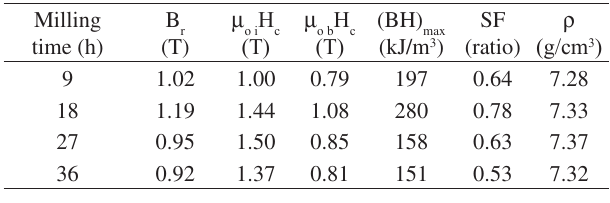
Table 1. Magnetic properties and density of Pr pared with powders milled for various times and sintered at 1060 °C (error: ±